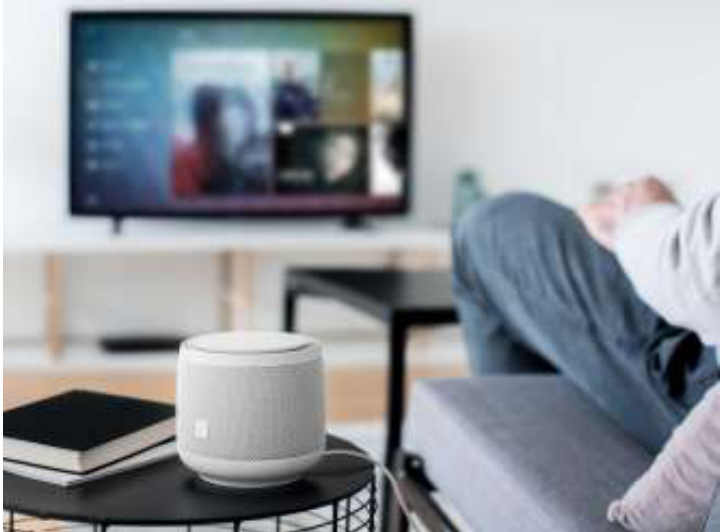
Figure 2. We cannot be sure who is giving voice commands to our assistant. Every year, several home gadget users report cases of strangers hacking into their voice assistants and transmitting commands. These incidents can be considered the first warning signs. How many cases of such fraud are still unknown? It is impossible to even imagine. Moreover, who is to blame? authentication for all the